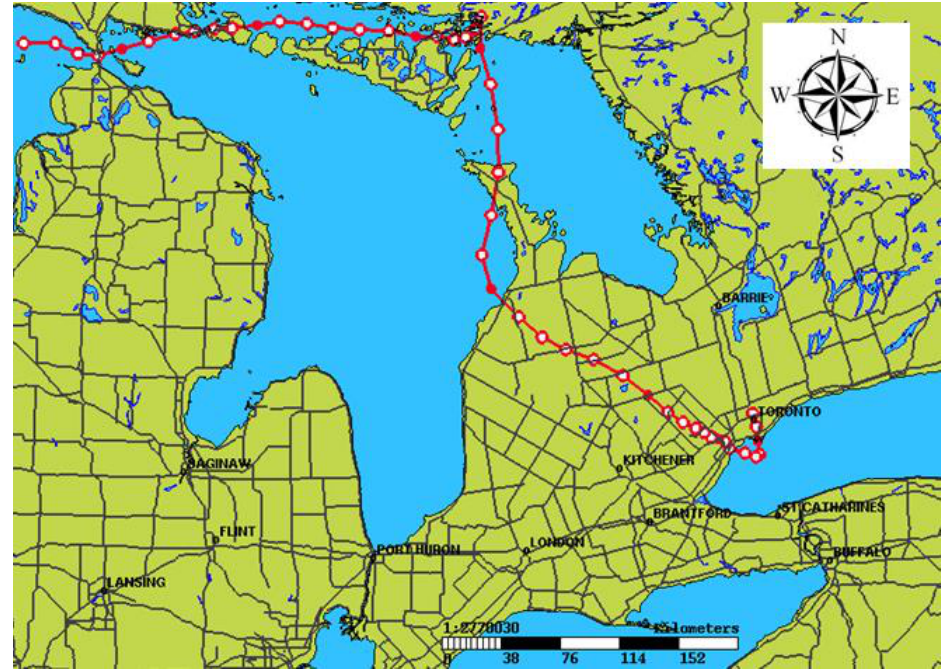
Figure 8. 48-h air mass back trajectory for North Toronto calculated from the 2.5-km GEM-MACH-TEB output at 20:00 UTC 28 July 2015.